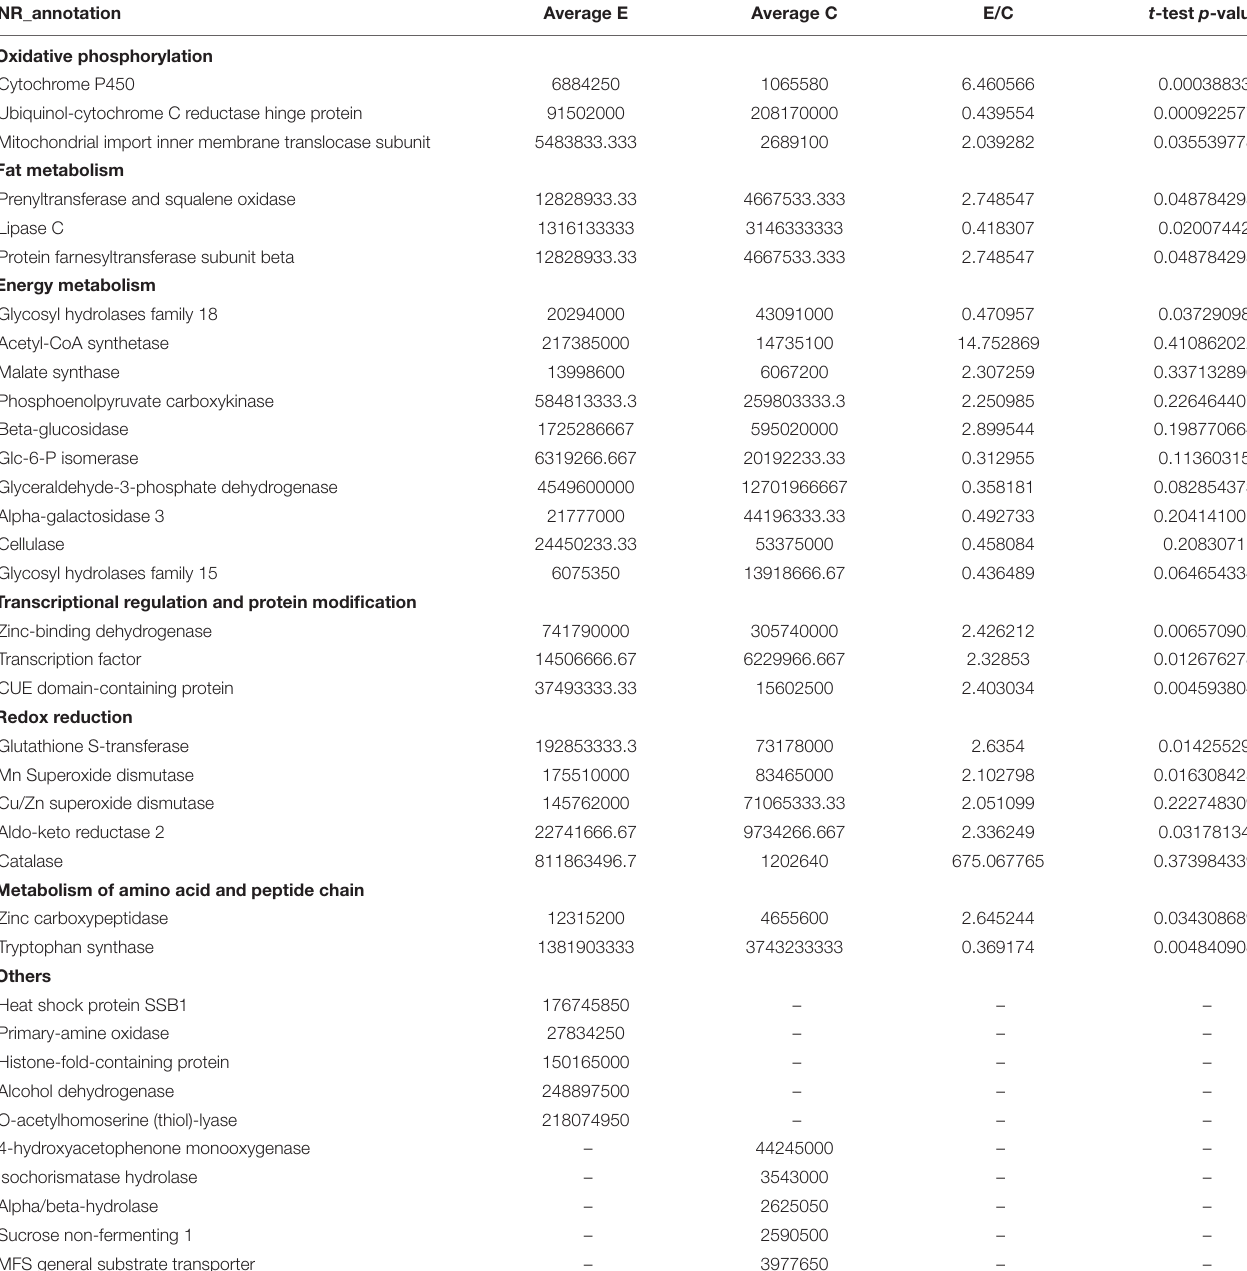
TABLE 1 | Identification of differentially expressed proteins in induced strains